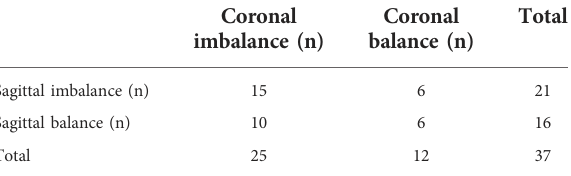
TABLE 5 Trunk imbalance in 37 patients with adolescent idiopathic scoliosis.